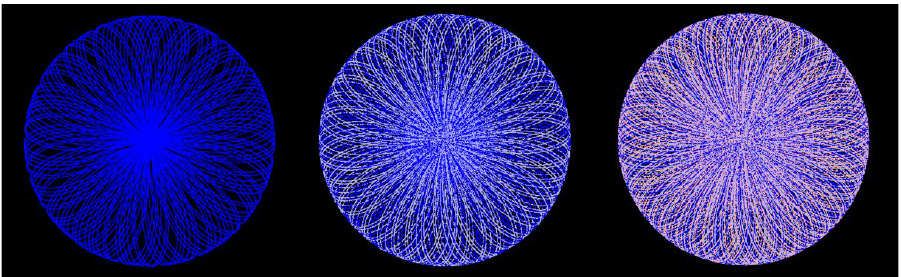
Figure 3. Rosette-style scan pattern of the Livox ® Mid–40, over a course of three seconds of operation. From left to right, each circle depicts the addition of one-second’s worth of data from a stationary scanner observing a stationary target surface.